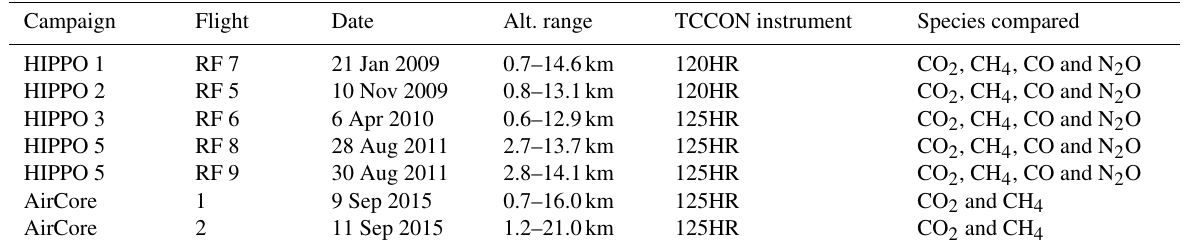
Table 3. Airborne calibration flights at the Lauder TCCON site. Campaign Flight Date Alt. range TCCON instrument Species compared HIPPO 1 RF 7 HIPPO 2 RF 5 HIPPO 3 HIPPO